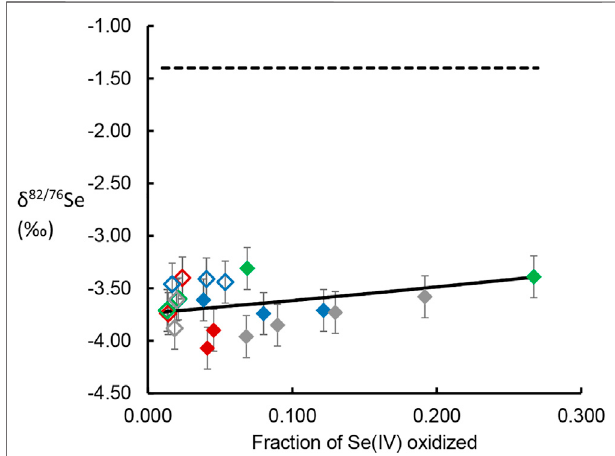
FIGURE1| δ 82/76 SevaluesofdissolvedSe(VI)generatedbyoxidationof Se(IV) by birnessite, plotted versus the fraction of the initial Se(IV) oxidized and released into solution. Data point colors follow the scheme used in Figures 4 , 5 , with red dots representing experimental conditions represented by orange. Closed symbols represent AR birnessite experiments; open symbol represent SG birnessite experiments. Dotted line gives the δ 82/76 Se value of the Se(IV) reactant stock solution. Solid line gives the line for a Rayleigh distillation model fi t to the data across all experimental